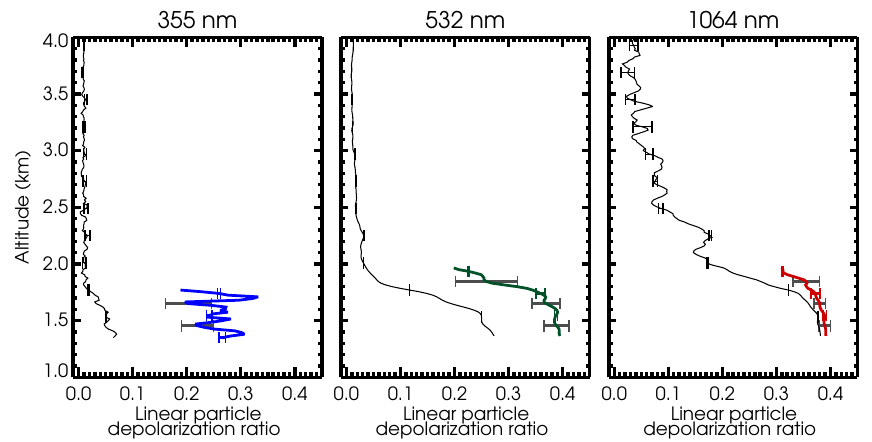
Figure 8. Line plots illustrating the volume and linear particle depolarization ratio profile for the HSRL-2 measurements at 17:08UT (17.14UT) on 8 Feb 2013. Error bars and resolutions as described for Fig. 5.